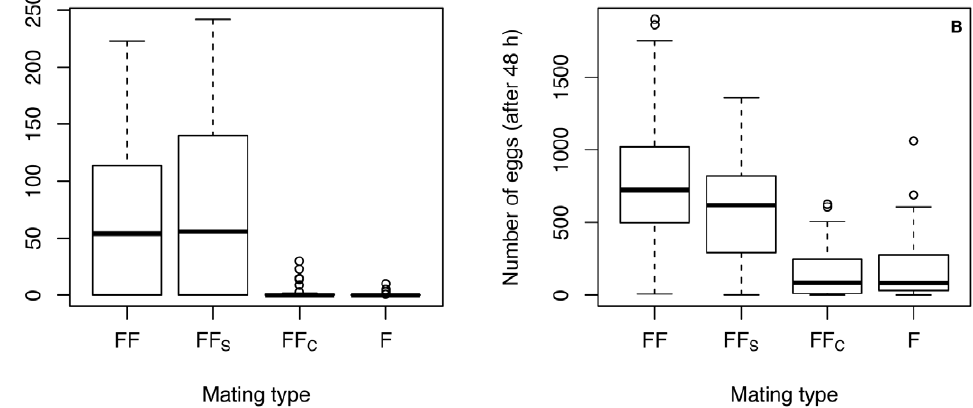
Figure 5. Gryllusfirmus female egg production. Box plot of egg production A ) 48 h following mating and B ) total lifetime for G. firmus females that (1) mated with a normal G. firmus male (FF), (2) mated with a G. firmus male that underwent sham testes removal surgery (FF S ), (3) mated with a G. firmus male surgically castrated (FF C ) or (4) remained unmated (F).